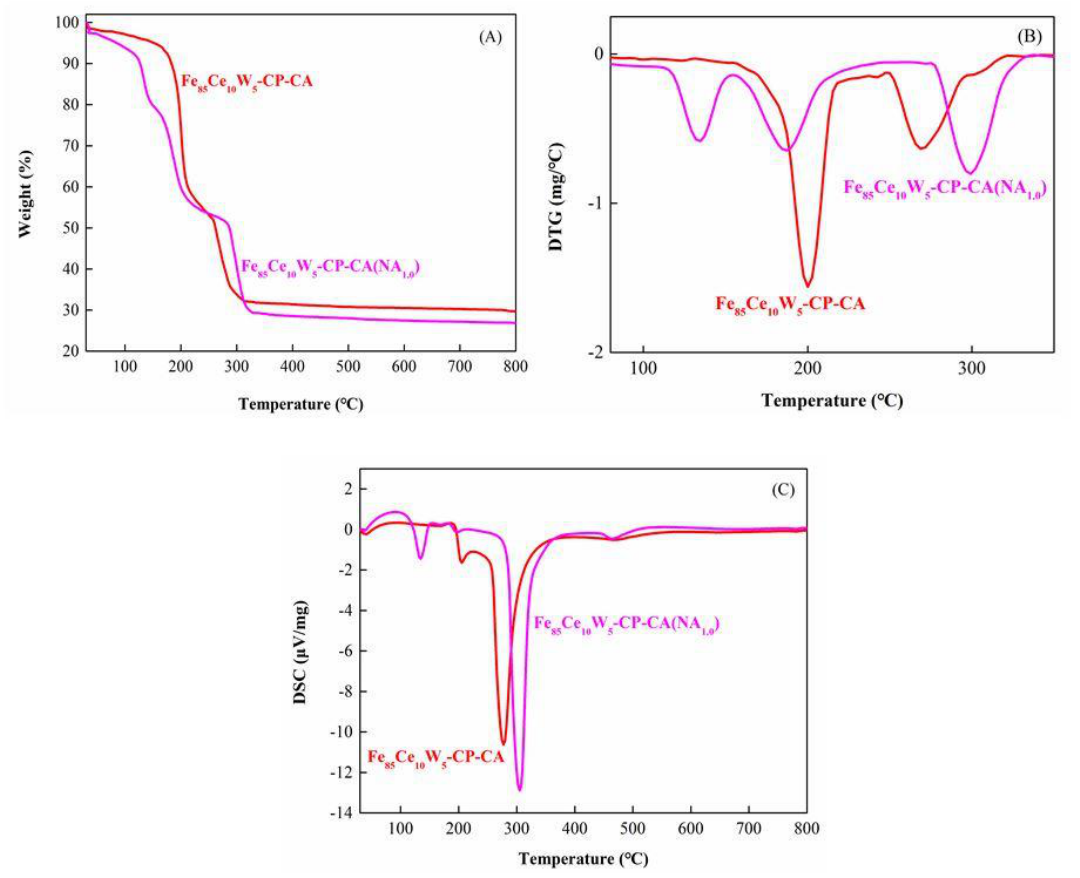
Figure 2. Thermal analysis curves of the precursor mixtures of Fe85Ce10W5–CP–CA and Fe85Ce10W5–CP–CA(NA1.0) recorded under an air atmosphere. (A) thermo-gravimetric (TG), (B) differential thermo-gravimetric (DTG), and (C) differential scanning calorimetry (DSC).